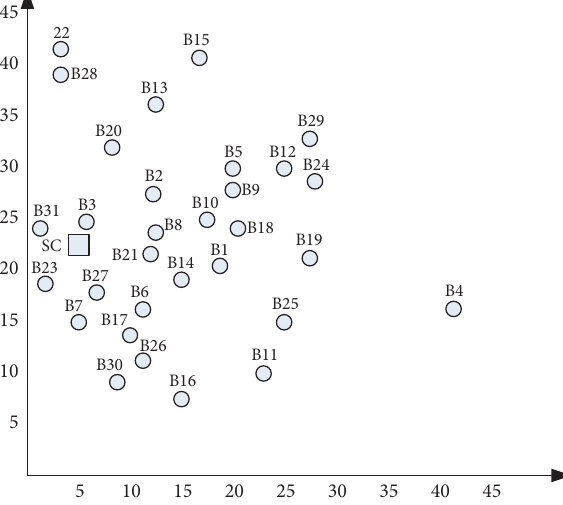
Table 3: Setting of the correlation coefficient.